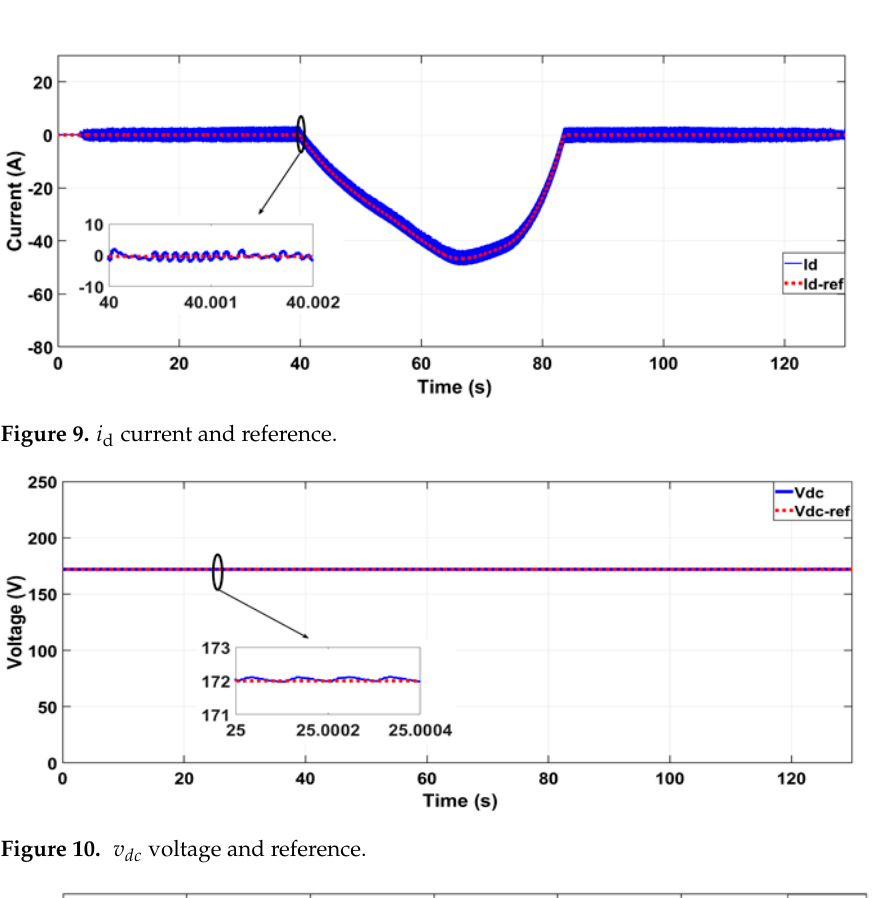
Figure 8. 𝑖 (cid:2927) current and reference.